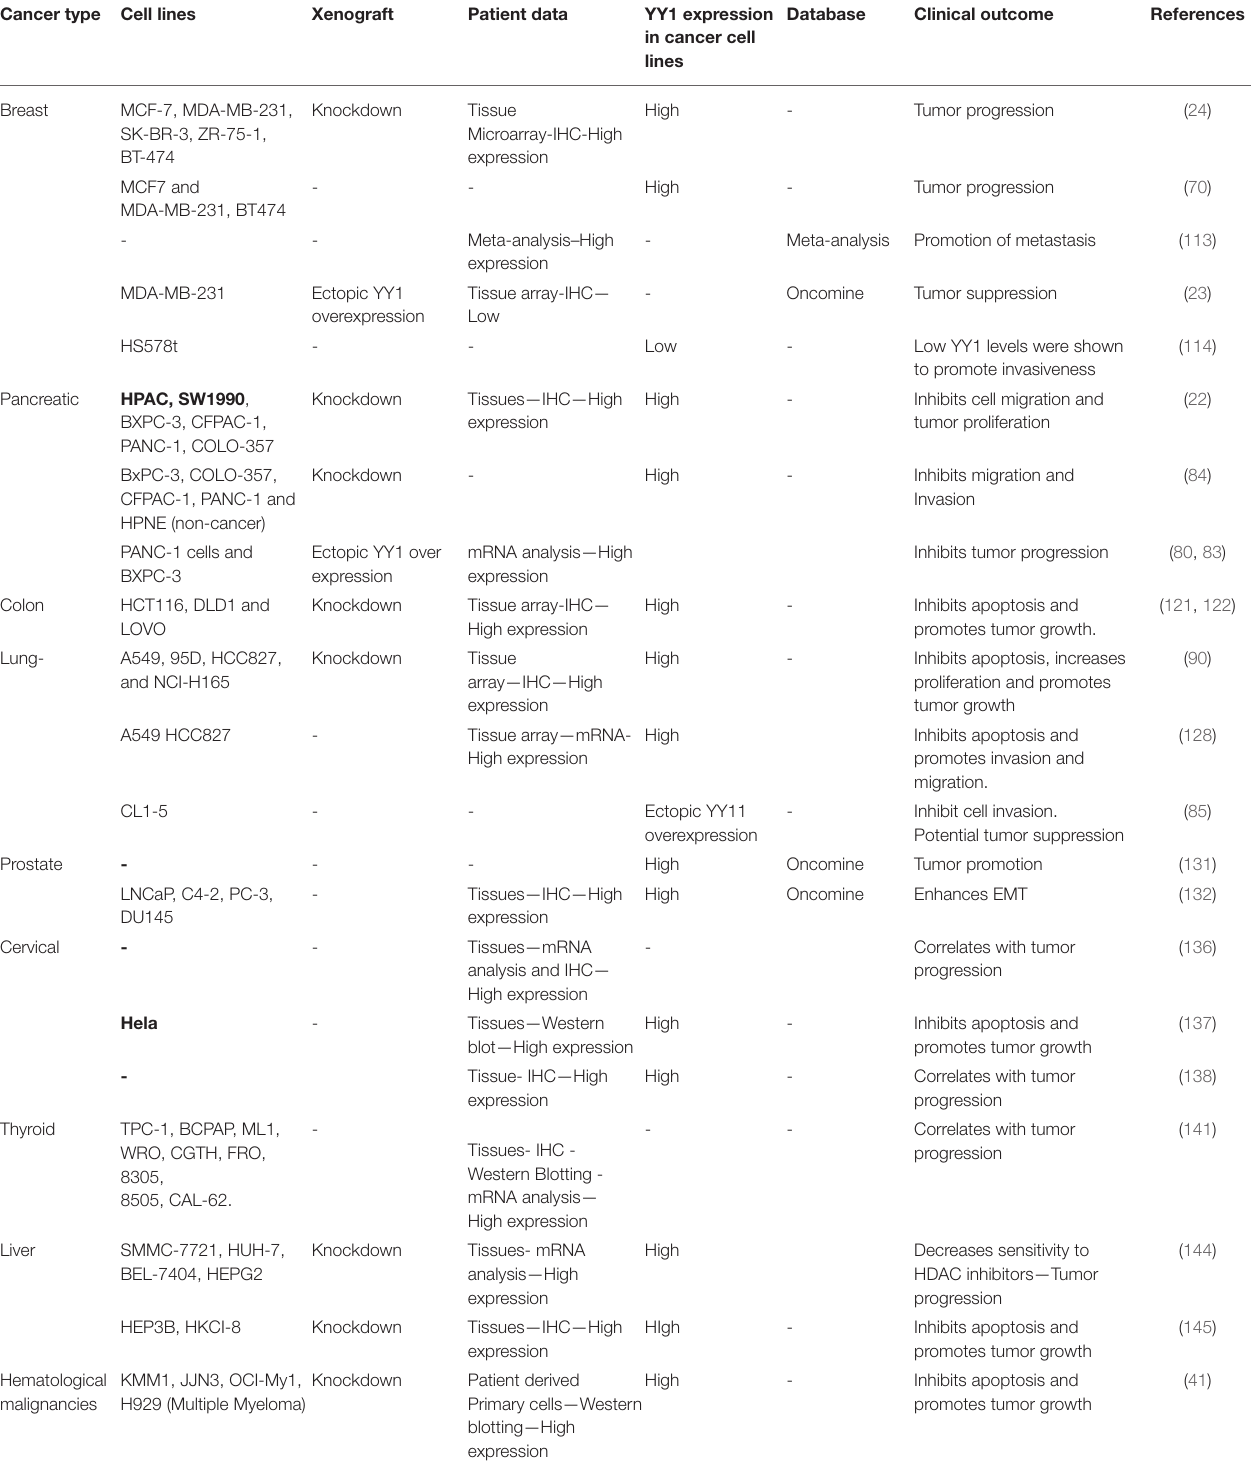
TABLE 4 | YY1 expression analysis in patient derived tumor samples, cancer cell lines, and xenografts. Cancer type Cell